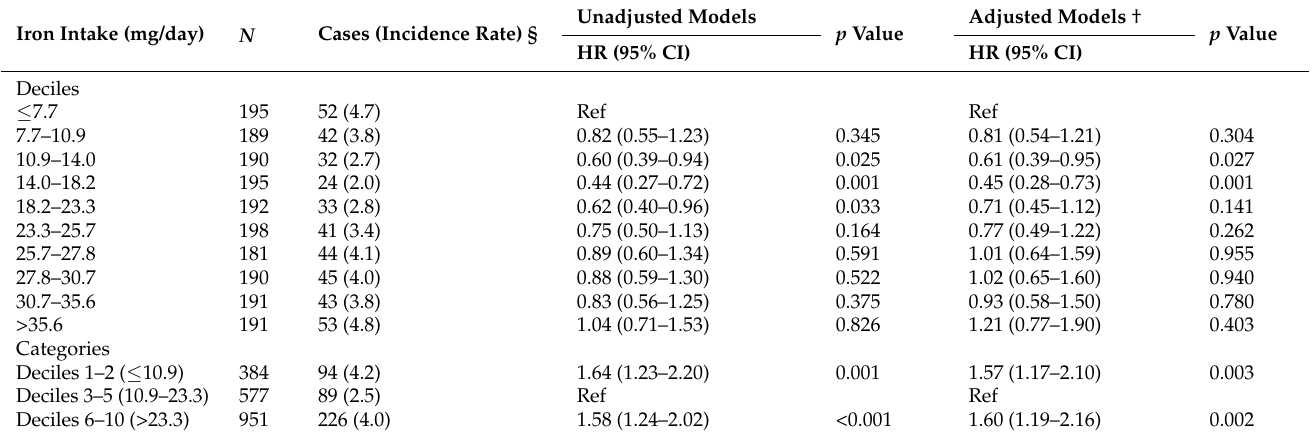
Table 3. The association between iron intake and the risk of KL-grade progression.